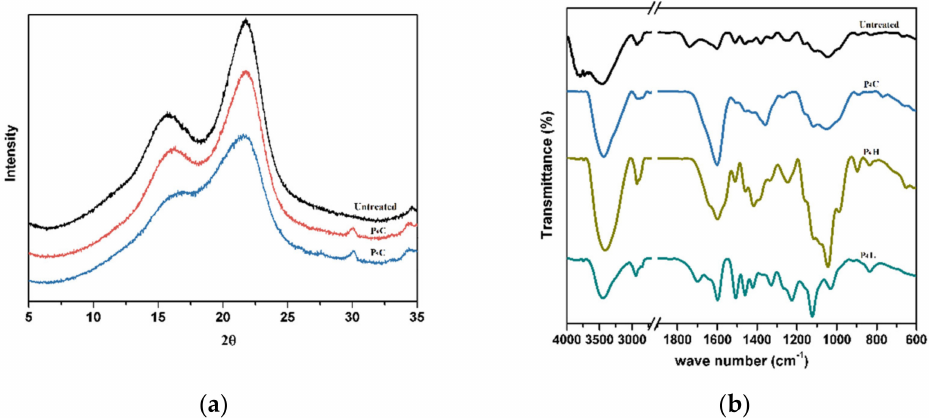
Figure 3. ( a ) X-ray diffractograms of the untreated and treated cellulosic fractions (untreated bamboo powder, P 4 C, and P 5 C); ( b ) FT-IR spectra of the raw and fractionated samples under wild conditions (untreated bamboo powder, P 3 C, P 3 H, and P 3